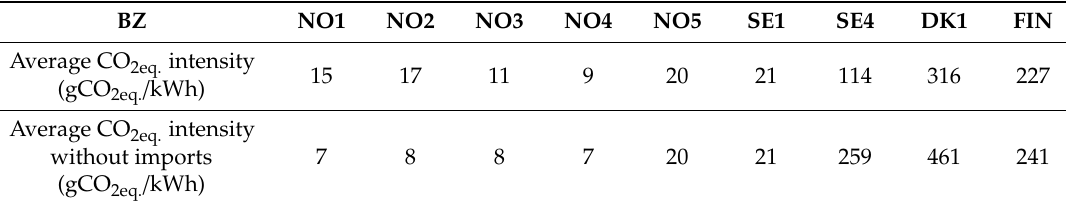
Table 2. Comparison of the annual average CO 2eq. intensities of the electricity mix for several Scandinavian bidding zones. BZ NO1 NO2 NO3 NO4 NO5 SE1 SE4 DK1 FIN Average CO 2eq. intensity 15 17 316 (gCO 2eq. / kWh)